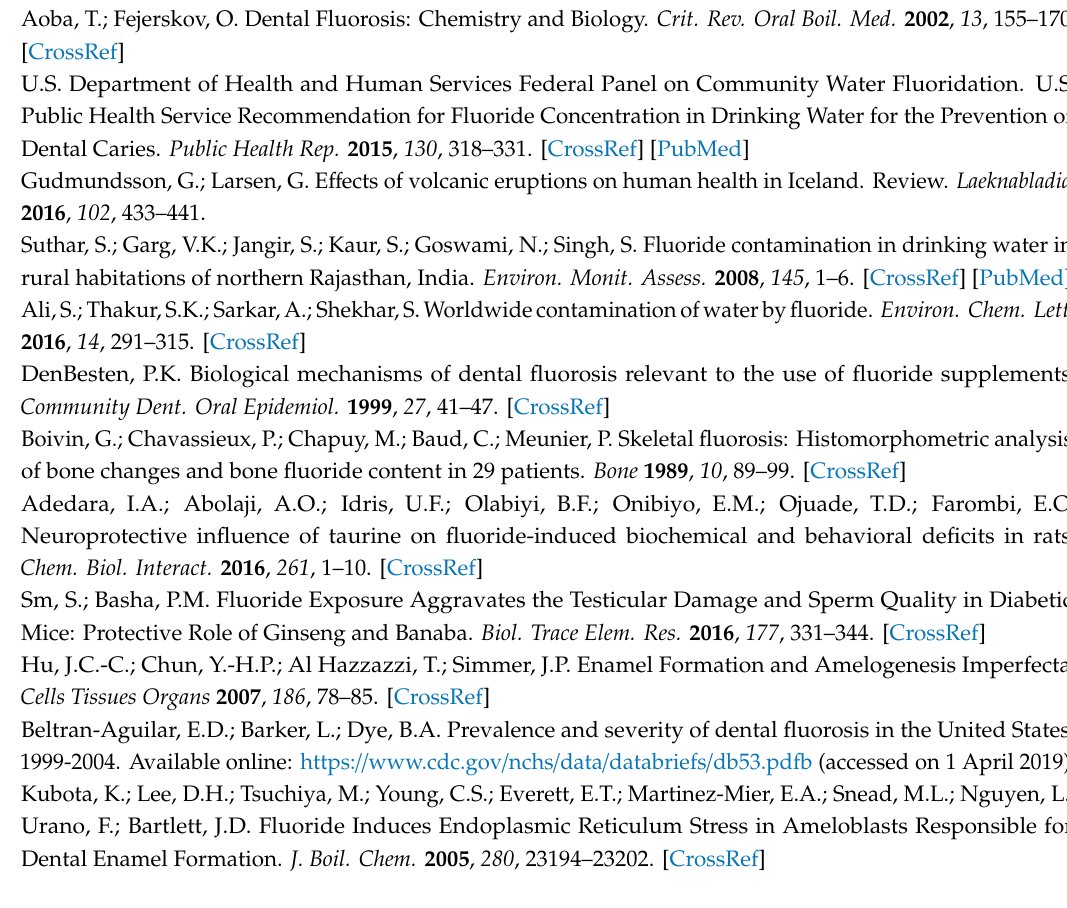
Figure S1: Fluoride induced formation of acetylated p53 (Ac-p53) in LS8 cells, Figure S2: E ff ect of Nutlin-3a and MG-132 on p21 mRNA expression in LS8 cells, Figure S3: E ff ect of Nutlin-3a and MG-132 on Bcl2 / Bax mRNA ratios in LS8 cells, Figure S4: Statistical analysis of Figure 1c, Figure S5: Statistical analysis of Figure 2b, Figure S6: Statistical analysis of Figure 3c, Figure S7: Statistical analysis of Figure 4b, Figure S8: Statistical analysis of Figure 7b, Figure S9: Statistical analysis of Figure 8, Table S1: Primers used for quantitative real-time